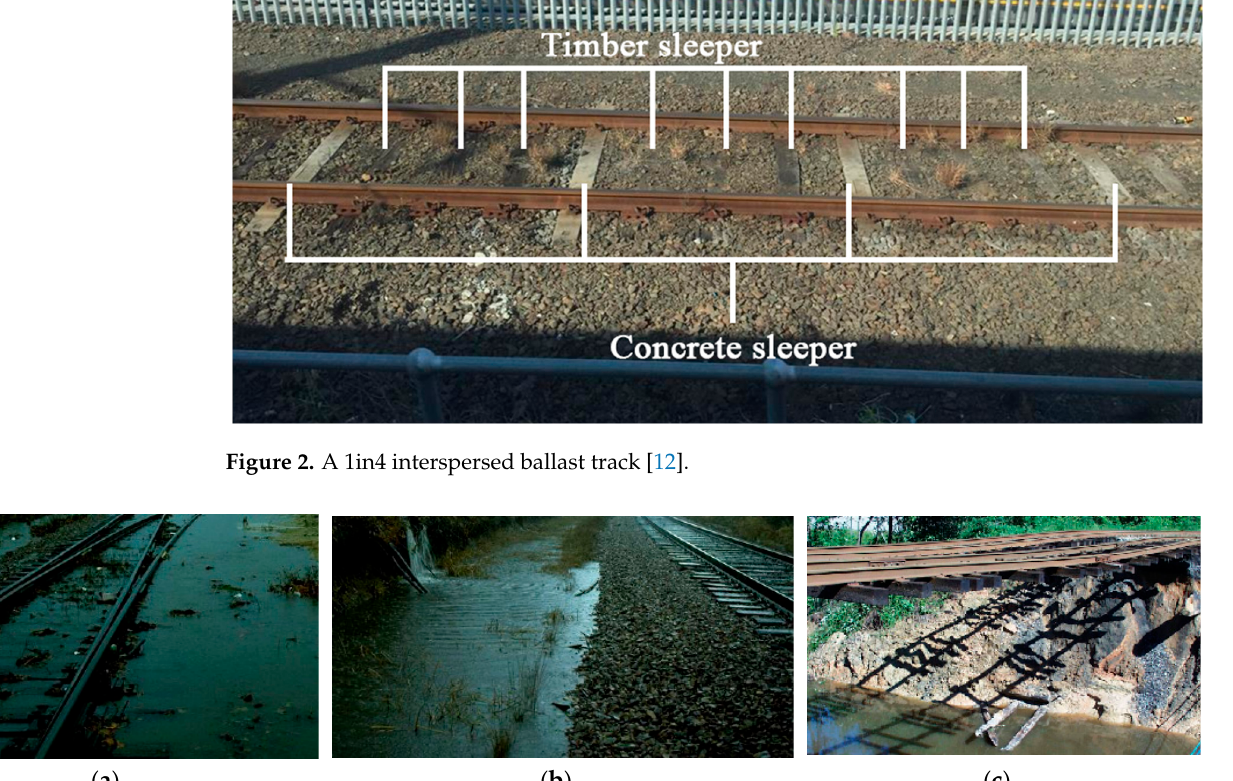
Figure 3. Typical track conditions caused by flood or heavy rain: ( a ) ballast drawn in water,( b ) sub- grade drawn in water, ( c ) fully unsupported sleepers caused by ballast and subgrade washing